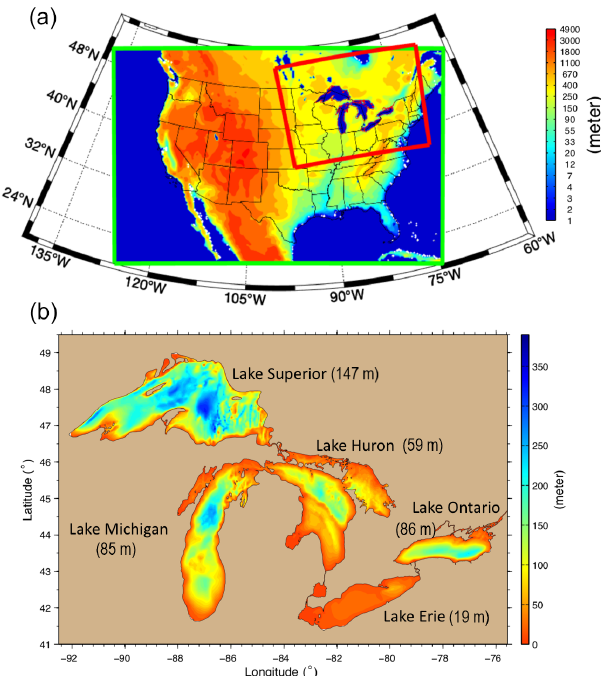
Figure 1. (a) The GLARM model domain (red box) overlaid on a topographic map of the majority of North America (green box). (b) Bathymetry map of the Great Lakes labeled with the average depth of each